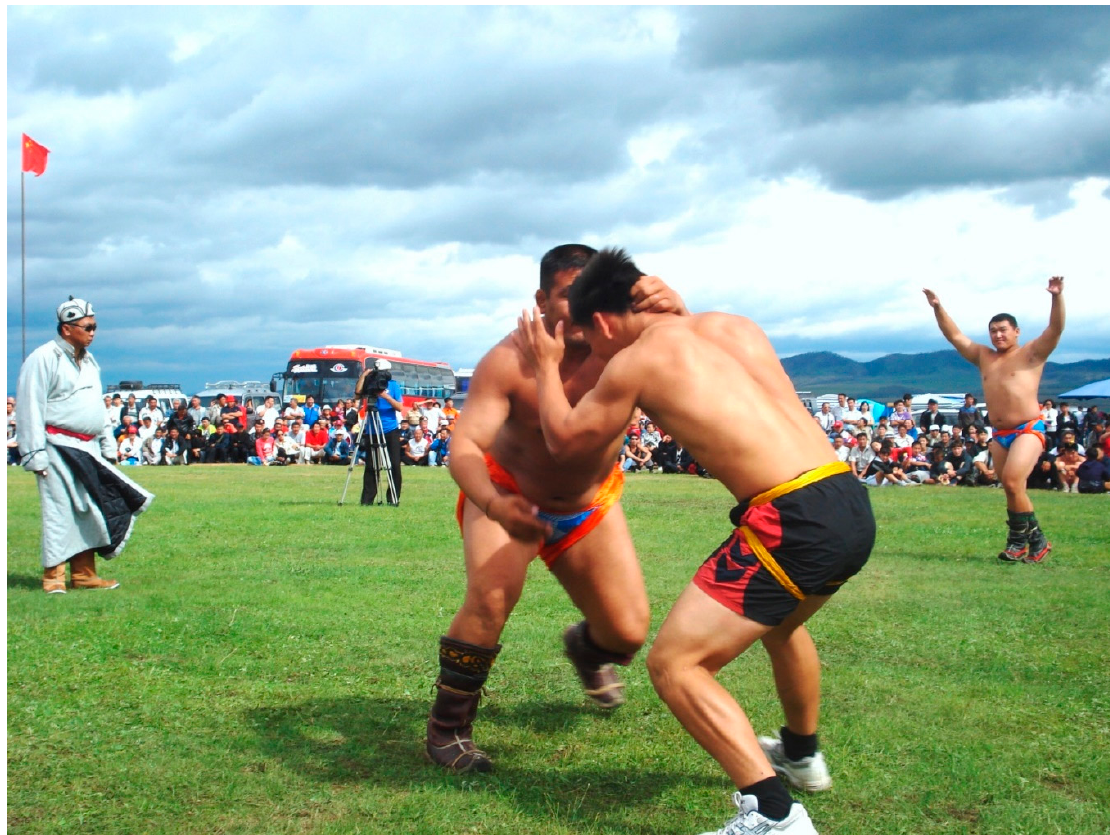
Figure 4. Buryat wrestlers, two engaged in a match and one performing the “devekh”, the eagle dance, during a wrestling tournament following an “oboo” ritual in China, Autonomous Region of Inner Mongolia, Hulunbuir City, in summer 2018. Photo: Stefan Krist.